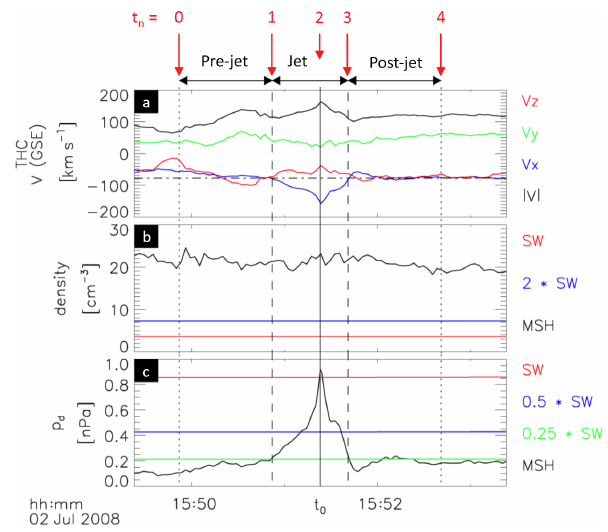
Figure 1. Figure showing a magnetosheath high-speed jet observed by THC. From top to bottom: (a) ESA ion velocity measurements in GSE, (b) ESA ion density measurements in black and (twice the) solar wind density measurements by OMNI in red (blue), (c) dy- namic pressure p d ,x measured by THC (black) as well as (1 / 4 and 1 / 2) the solar wind value in red (green and blue). On top, the pre-jet, jet, and post-jet intervals are marked; normalized times are given in red. Figure modified from Fig. 1 in Plaschke et al.